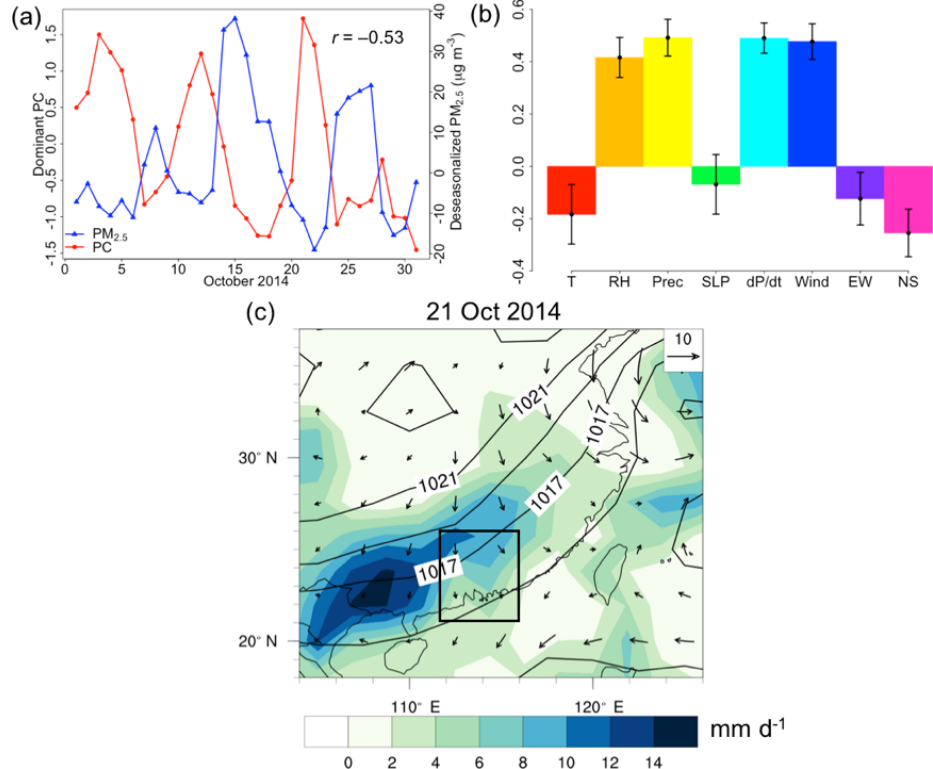
Figure 5. Same as Fig. 3 but for fall in the Pearl River Delta (PRD). (a) Deseasonalized total PM 2 . 5 concentrations and the PC time series in the sample month of October 2014. (b) Composition of this dominant mode as measured by the coefficients α kj . (c) Synoptic weather map on 21 October 2014, corresponding to the positive influence from the mode, with precipitation (mmd − 1 ) as shaded colors, wind speed (ms − 1 ) as vectors, and sea level pressure (hPa) as contours. The rectangle indicates